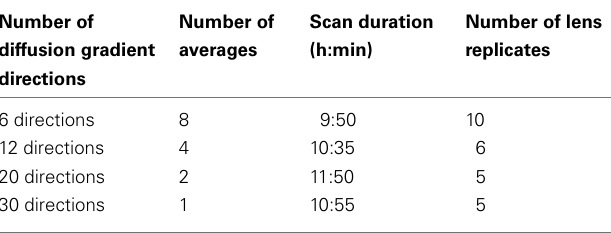
Table 1 |A series of DTI experiments performed on the bovine lens to evaluate the effects of gradient directions and signal